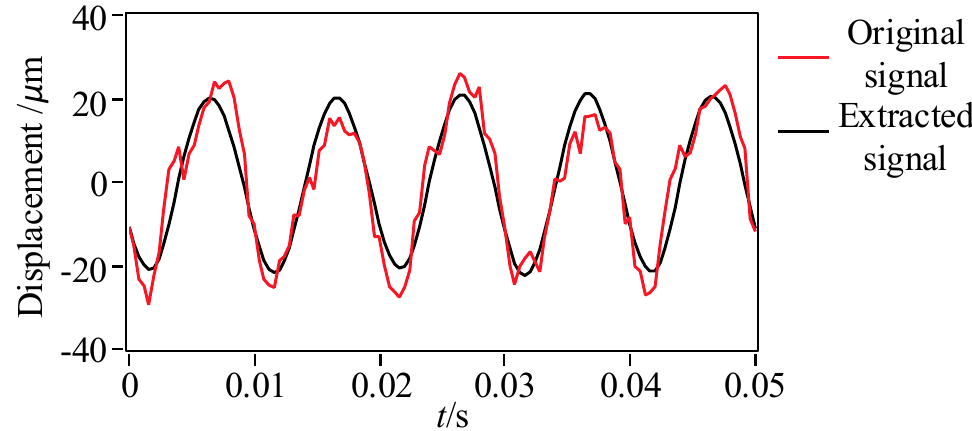
Figure 5. LMS algorithm real-time extraction effect .